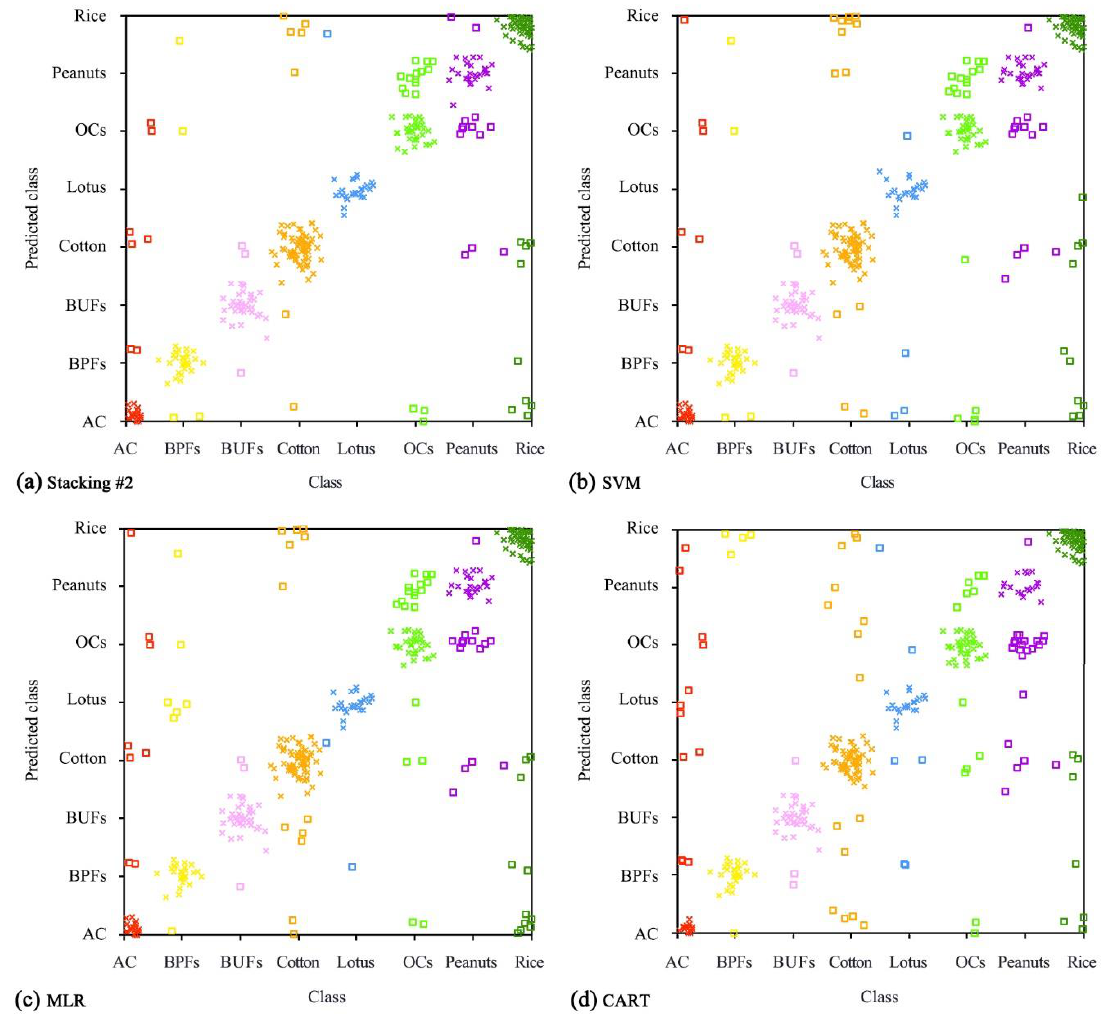
Figure 8. Error visualization of the Stacking #2 ( a ), SVM ( b ), MLR ( c ) and CART ( d ) classifiers. ‘×’ and ‘ □ ’ represent the correctly and incorrectly predicted instances, respectively.